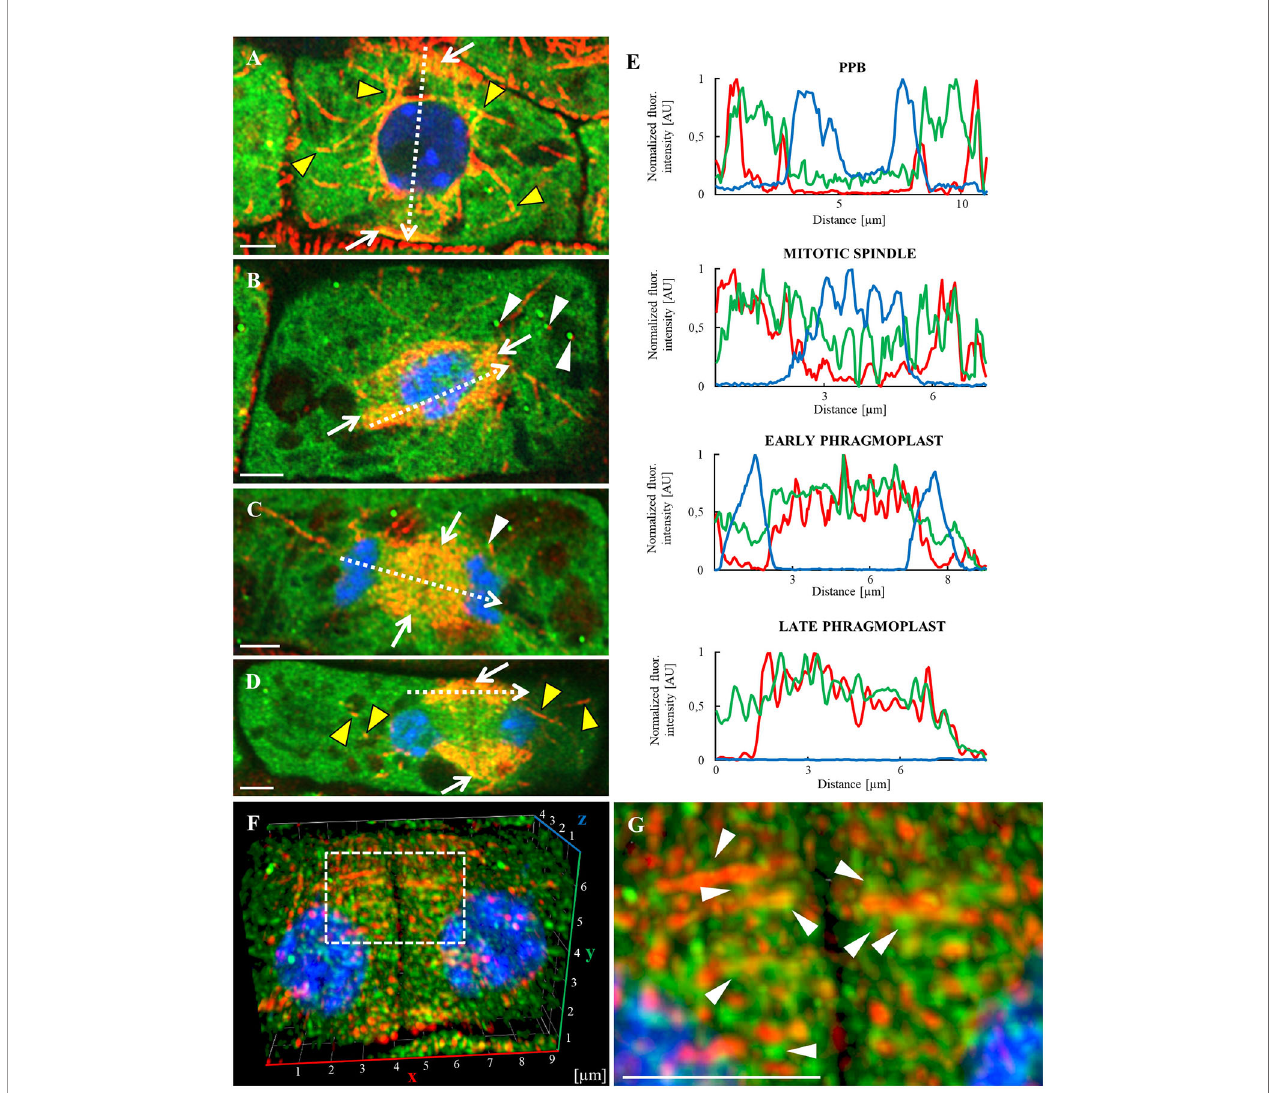
FIGURE 10 | Whole-mount immuno fl uorescence colocalization study of microtubules (red) and ANN1-GFP (green) in dividing lateral root cap cells made by Airyscan CLSM. Nuclei are labeled with DAPI (blue), while individual division stages (indicated by white arrows) are depicted as merged images: (A) Preprophase band (PPB), (B) mitotic spindle, (C) early phragmoplast, and (D) late phragmoplast. Yellow arrowheads indicate the association of ANN1-GFP with microtubules, white arrowheads point to the association of spots containing ANN1-GFP with microtubules. Individual images of microtubules in red, ANN1-GFP in green, and DNA in blue corresponding to merged images (A – D) are shown in Figure S10. (E) Fluorescence intensity pro fi les of ANN1-GFP distribution were measured in indicated cell division stages along dotted arrows depicted in (A – D) and normalized. Green lines represent ANN1-GFP, red microtubules, and blue DAPI. (F) Frontal view of lateral root cap cell (3-D rendered) showing late phragmoplast. (G) Detail of ANN1-GFP spot-like localization pattern (white arrowheads) closely associated with phragmoplast microtubules of dotted boxed area in (F) . Scale bars = 2